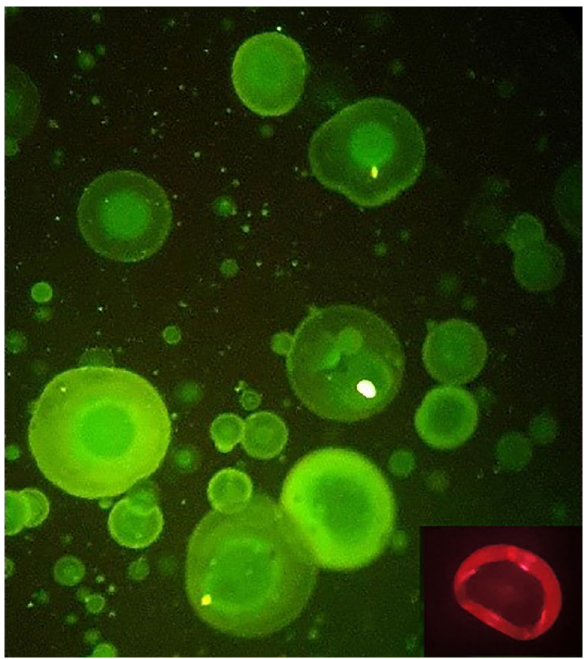
Figure 4. An optical microscope image of fluorescent emission of carboxyfluorecin-stained microparticles. Insert shows the fluorescent emission of Nile-Red-stained